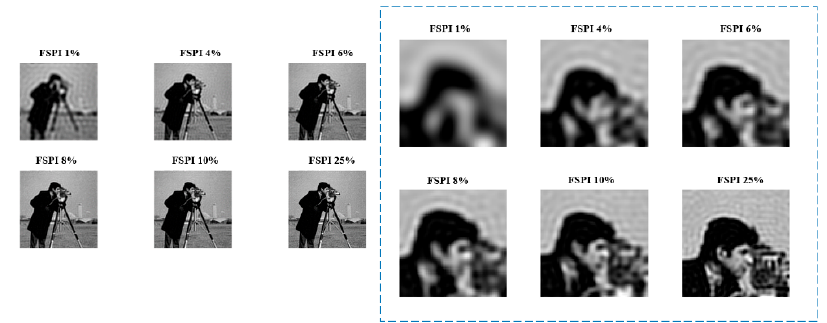
Figure 3. FSPI reconstruction for cameraman test image for 1–25% sampling rate. Right-side dotted box shows left side images zoomed in.